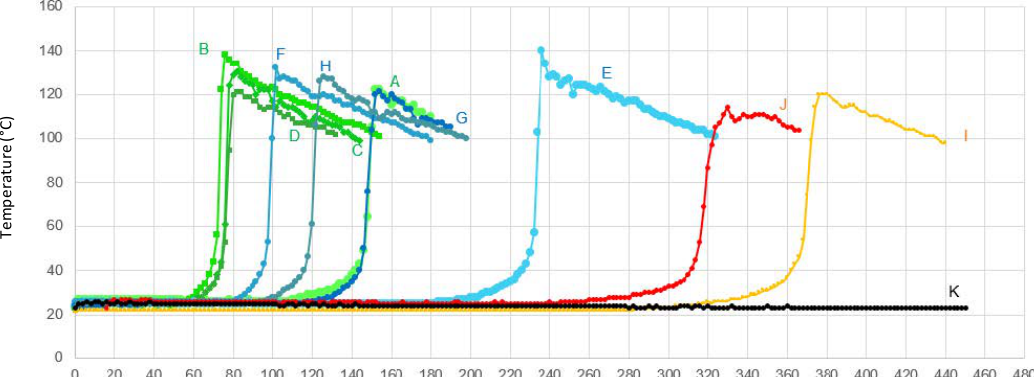
Figure 5. Optical pyrometric measurements (temperature vs. time after mixing; 4 mm thick sample) under air for the BM resin for Redox FRP using different RISs based on T4epa/Iod-Cl (1%/2% w/w ) in presence of different salts: ( A ) NaPF 6 (0.5% w/w ); ( B ) NaPF 6 (2% w/w ); ( C ) NaPF 6 (1% w/w ); ( D ) NaPF 6 (1.5% w/w ); ( E ) LiTFSI (0.63% w/w ); ( F ) LiTFSI (2% w/w ); ( G ) LiTFSI (1% w/w ); ( H ) LiTFSI (1.5% w/w ); ( I ) NaBF 4 (1% w/w ); ( J ) NaBF 4 (3% w/w ); ( K ) without additional salt.